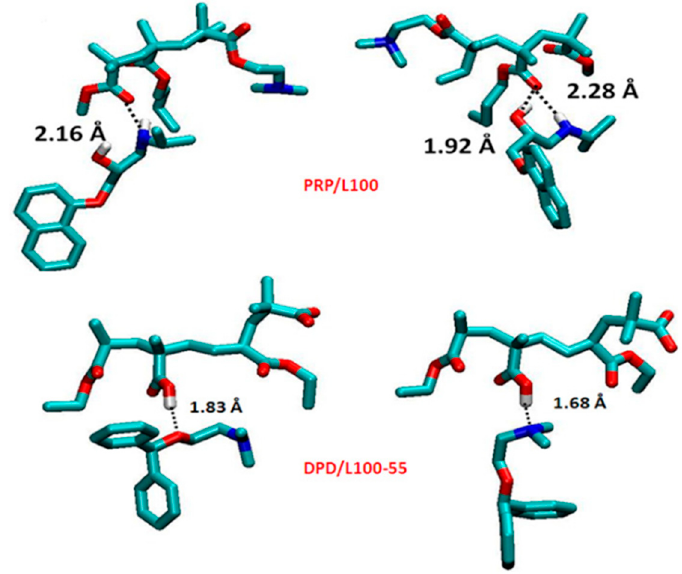
Figure 3. Hydrogen bonding patterns of propranolol/Eudragit L100 (PRP/L100) and diphenhydramine/L100-55 calculated by Gaussian 09. (Adapted with permission from [73], Elsevier, Inc., 2017.)